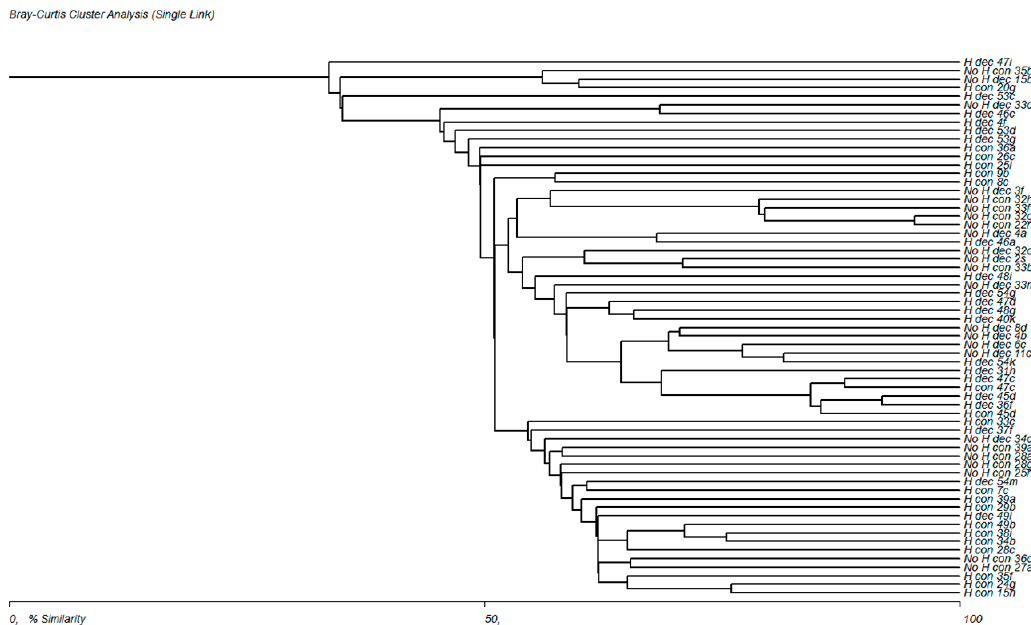
Figure 2. The similarity for clusters of shrub and understory layer species growing in all areas under examination; (H—horse present, No H—horse absent, con—coniferous forests (CF), dec—deciduous forests (DF); 7c, 54g—codes of the forest sub-compartment.